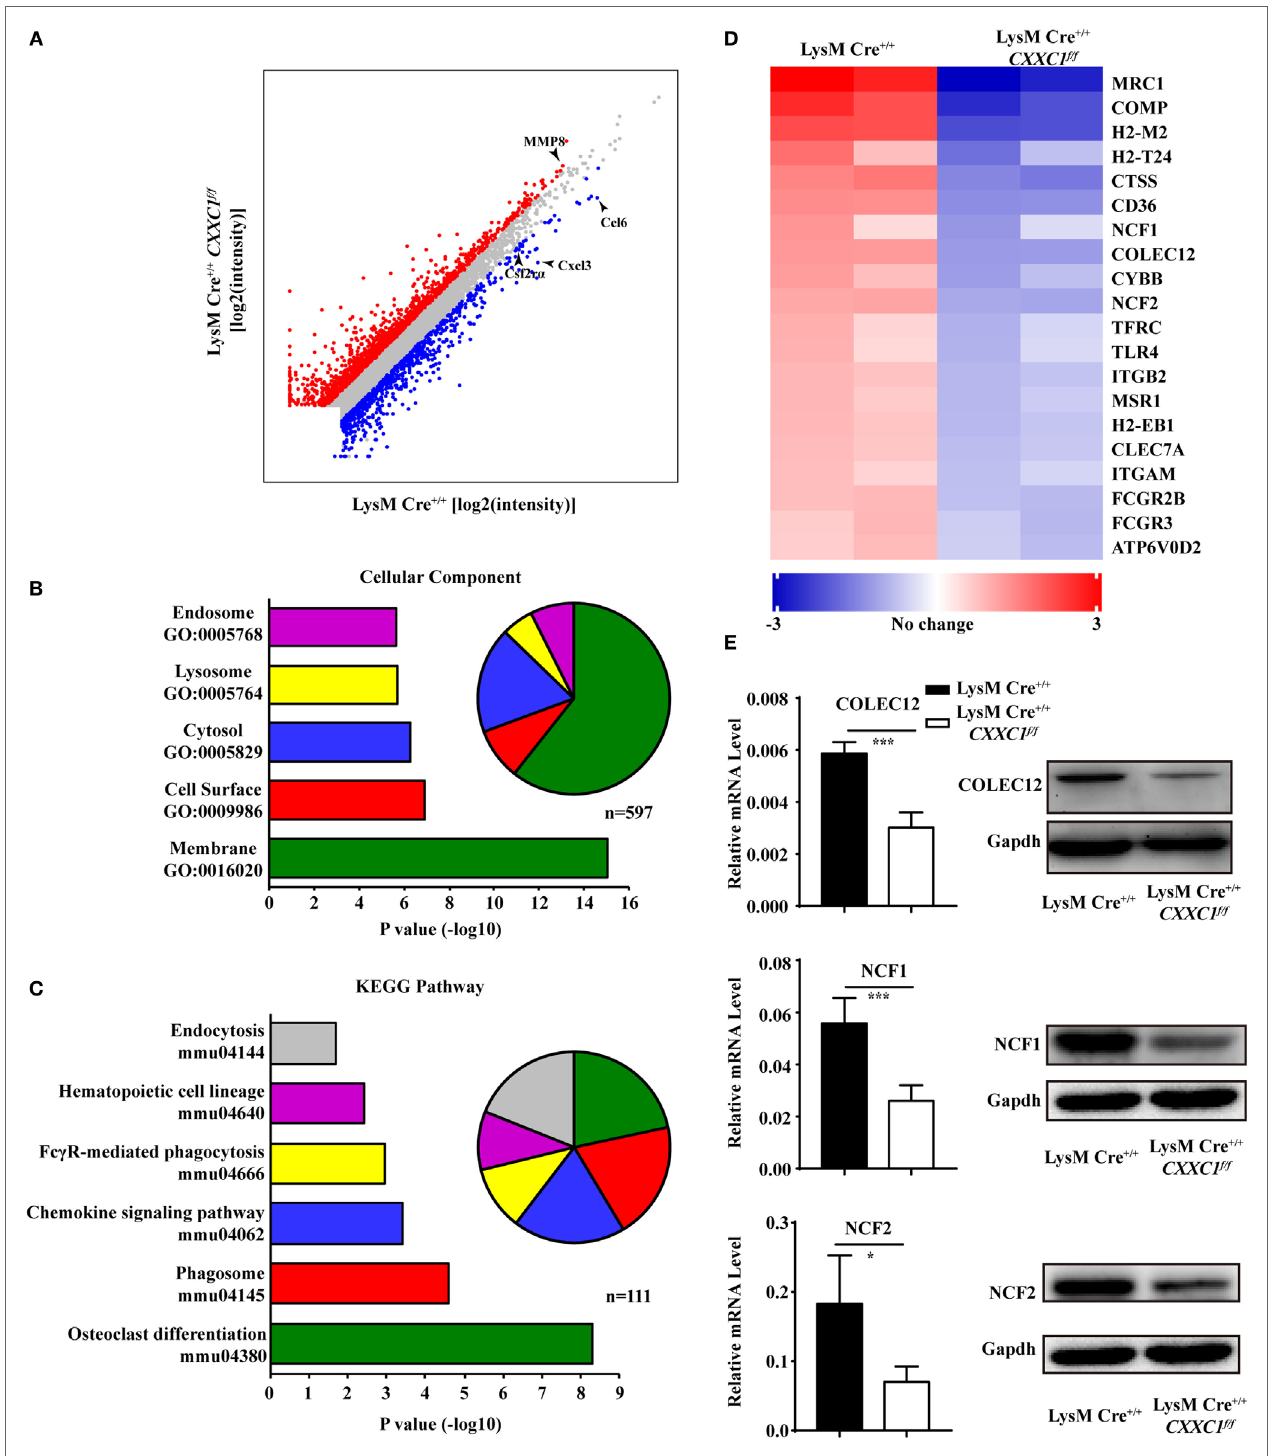
FigUre 3 | Cxxc finger protein 1 (CFP1)-deficient macrophages showed decreased expression of phagosome pathway-related genes. (a) Scatter plot showing gene expression changes in wild-type and CFP1-deficient macrophages. Downregulated genes are indicated in blue; upregulated genes, in red. (B) GO analysis of the downregulated genes. Left: enriched GO categories ( P < 0.05). Right: pie chart showing the number of genes in each GO category. (c) KEGG analysis of the downregulated genes. Left: enriched GO categories ( P < 0.05). Right: pie chart showing the number of genes in each GO category. (D) KEGG pathway analysis of genes in phagosome-related pathways, presented as the expression in CFP1-deficient macrophages relative to that in wild-type macrophages. (e) The mRNA and protein level of COLEC12, NCF1, and NCF2 in wild-type (black rectangle) and CFP1-deficient (white rectangle) macrophages. The mean and SD of four independent experiments are shown. * P < 0.05 and *** P < 0.001 indicate significant differences between groups as determined by Student’s t